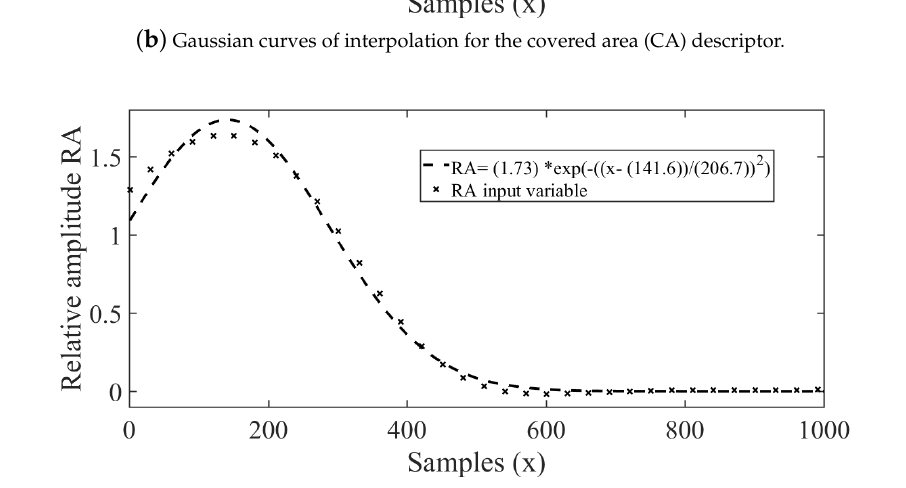
( c ) Gaussian curves of interpolation for the relative amplitude (RA) descriptor. Figure 10. Models for the interpolation of the quality descriptors based on the Gaussian